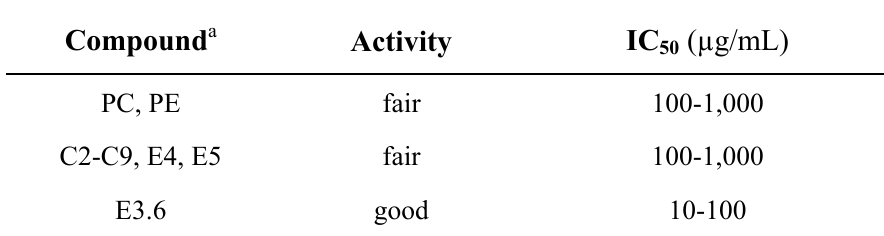
Table 2. Antimalarial activity of P.